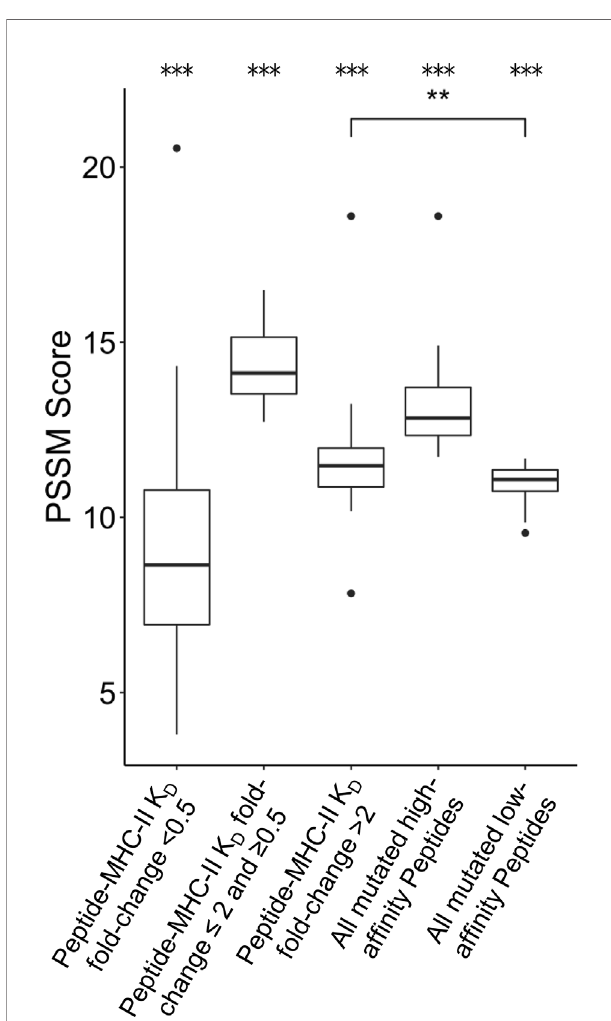
FIGURE 5 | Position-Speci fi c Scoring Matrix (PSSM) distributions for peptide mutations present in FDA-approved mAbs, binned by peptide: MHC-II KD changes. Peptides were matched to V-gene germline peptides after peptide K D prediction. For each group, the mean PSSM scores for each DRB1 allele with median and interquartile ranges are shown. Peptides mutated from high af fi nity germline peptides (K D < 1,000 nM) were grouped based on K D fold-change from germline. The complete set of high af fi nity and low af fi nity peptides (K D < 1,000 nM) is also shown. Differences between groups was determined by a Welch Two Sample t-test, and p-values were adjusted for multiple comparisons. A total of 3,135 peptides were analyzed. ***p-value < 0.001 for comparisons between all groups, except when noted. **p-value < 0.01.